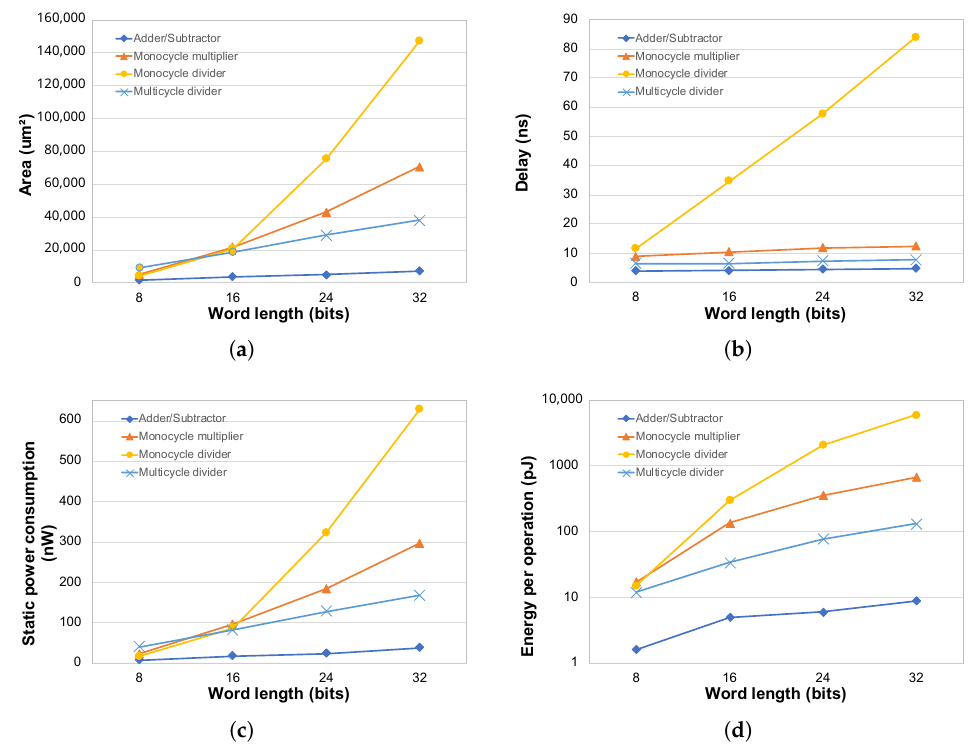
Figure 11. Integer arithmetic unit characterization in terms of data word length. ( a ) Area. ( b ) Delay. ( c ) Static power. ( d ) Energy per